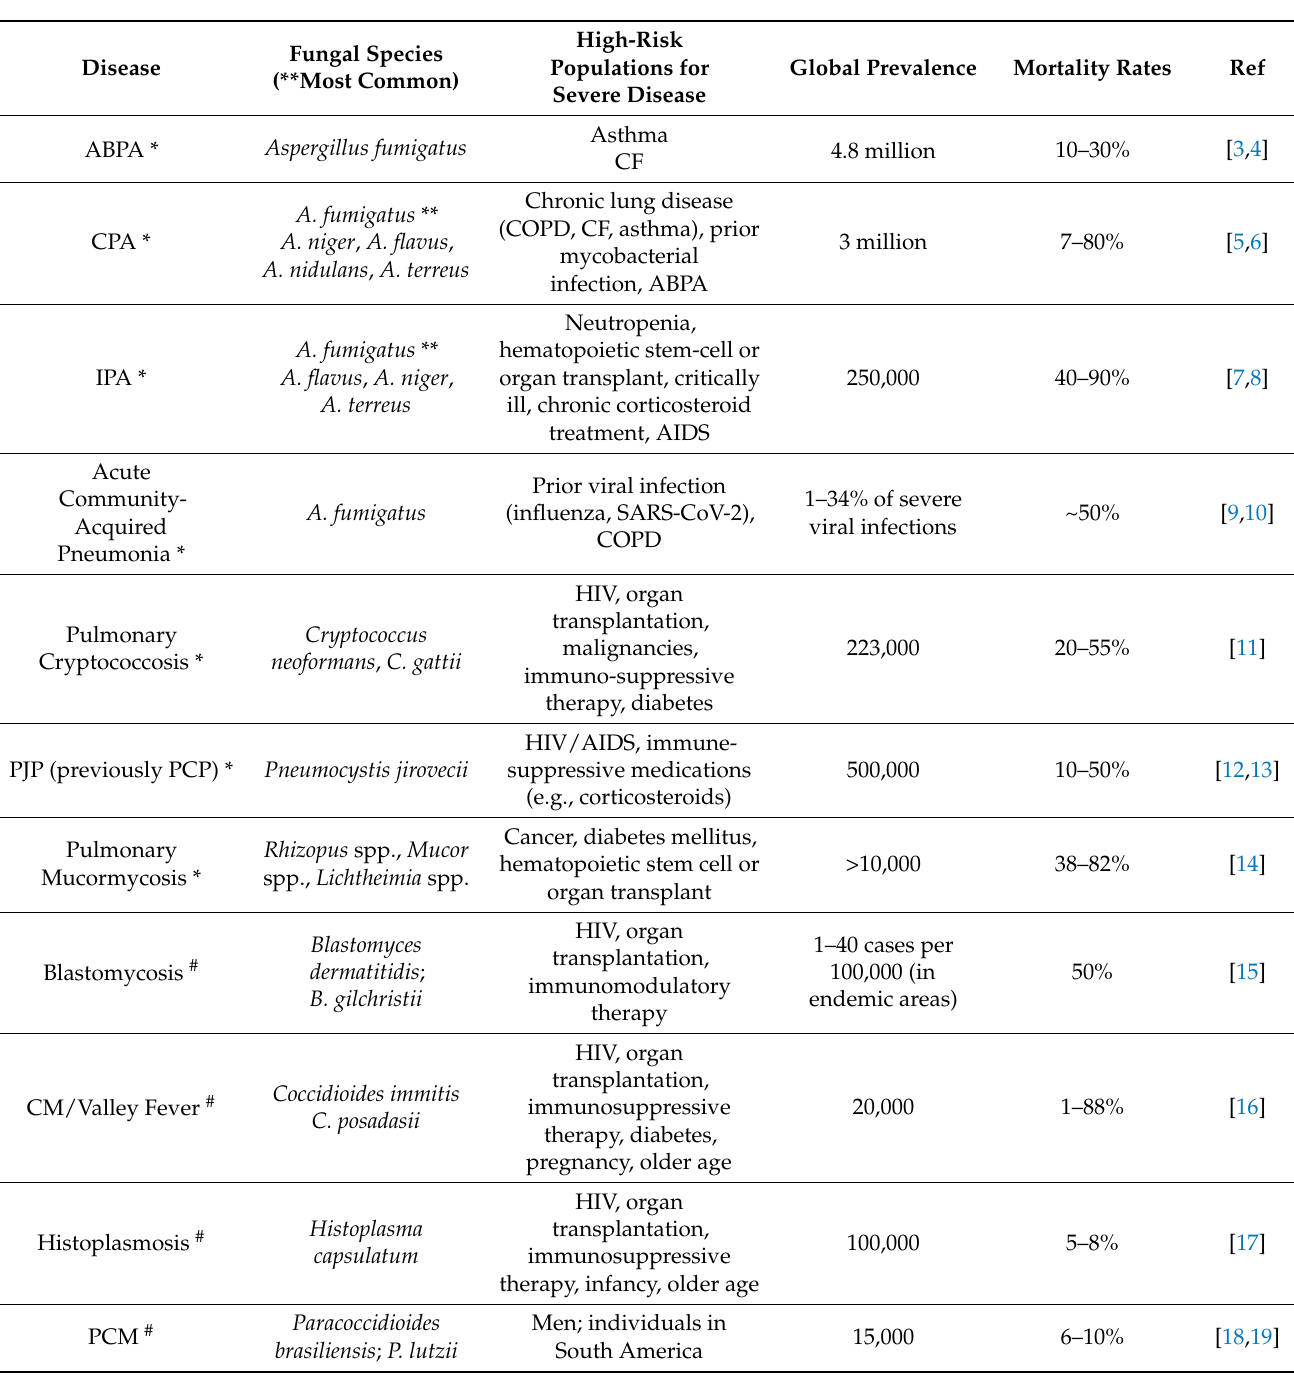
Table 1. Common pulmonary fungal infections. ABPA = allergic bronchopulmonary aspergillosis; CF = cystic fibrosis; CPA = chronic pulmonary aspergillosis; COPD = chronic obtrusive pulmonary disease; IPA = invasive pulmonary aspergillosis; PCP = Pneumocystis pneumonia; CM = coccid- ioidomycosis; PCM =